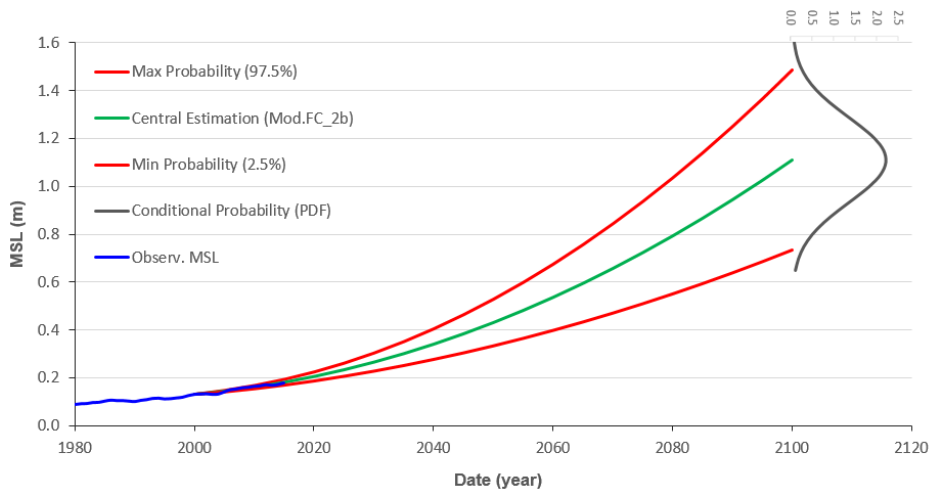
Figure 8. Relative SLR projection of Mod.FC_2b (in meters) with probability limits of 95% confidence, superimposed with a PDF at epoch 2100 (fitted to the MSL y -axis) and observed MSL at Cascais TG, relative to the national vertical datum of Cascais 1938 (13 cm at epoch 2000).